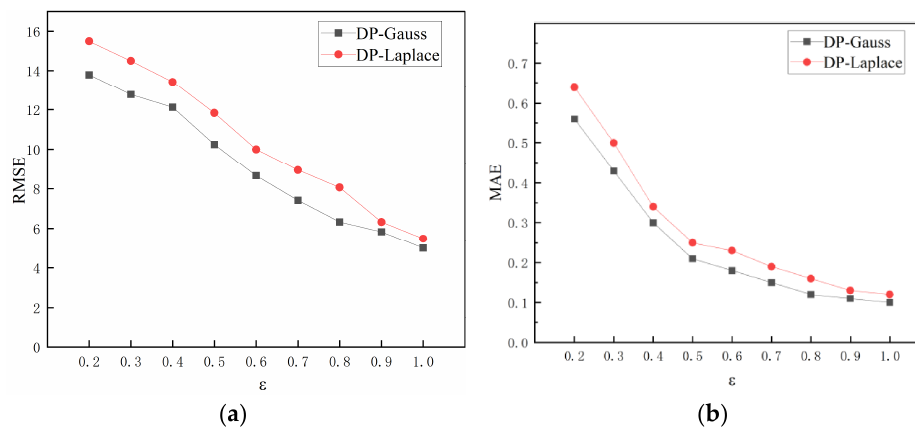
Figure 14. Error comparison chart: ( a ) root mean square error; ( b ) average absolute error.